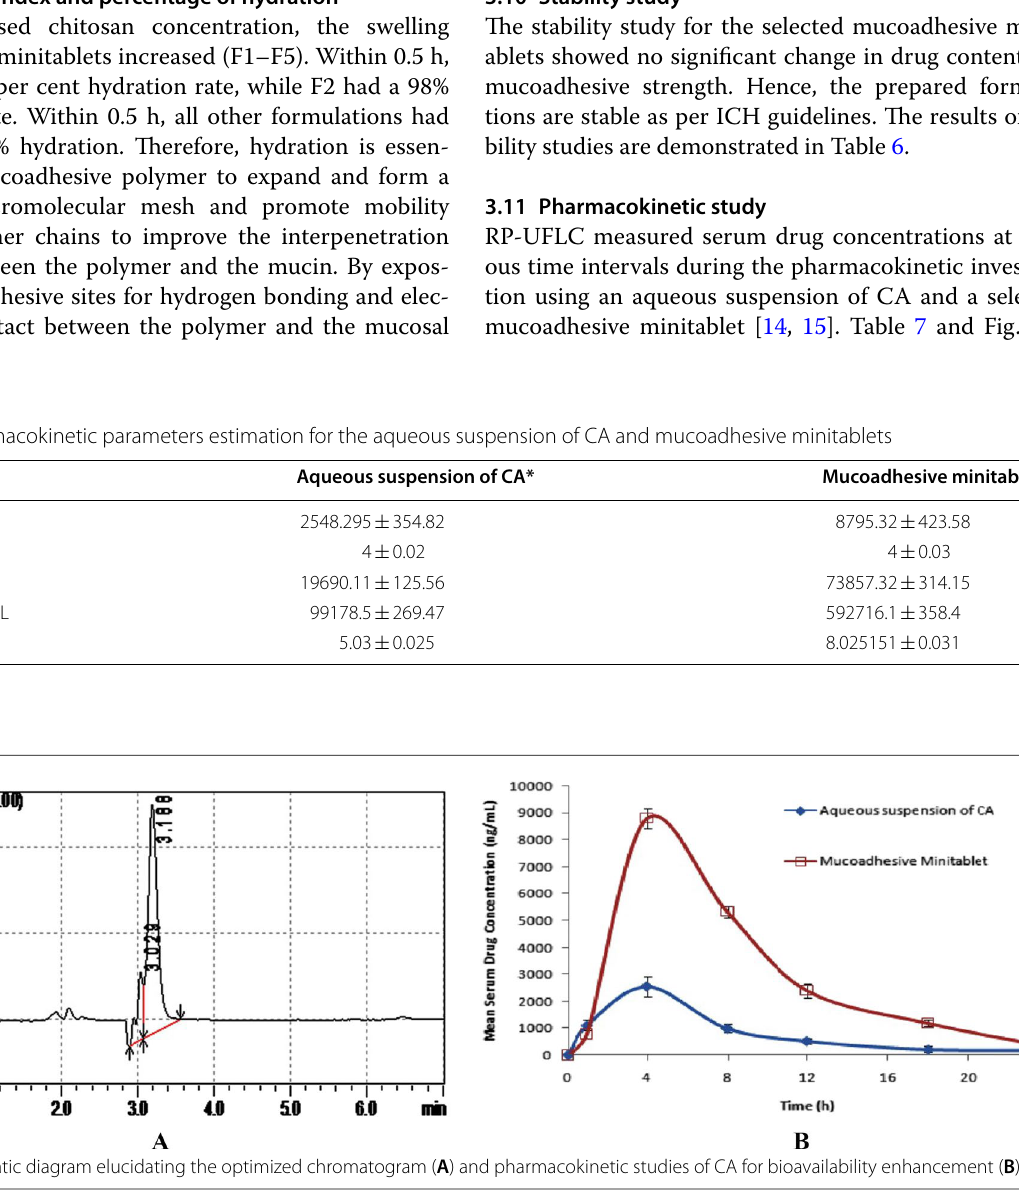
Fig. 7 Schematic diagram elucidating the optimized chromatogram ( A ) and pharmacokinetic studies of CA for bioavailability enhancement ( B